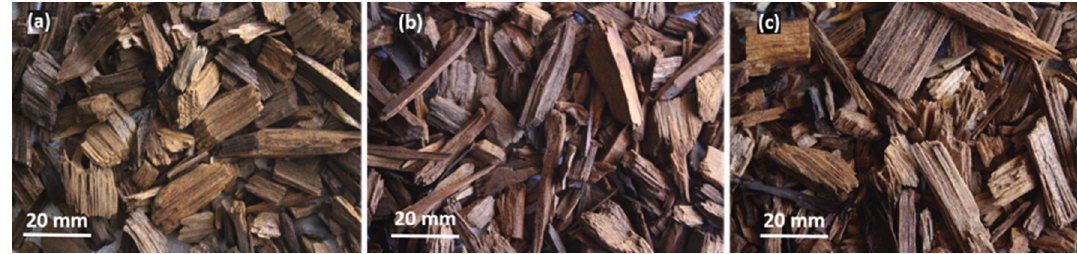
Figure 5. ( a ) Series 3: T7; ( b ) Series 3: T8; and ( c ) Series 3: T9, which presents a brownish color.